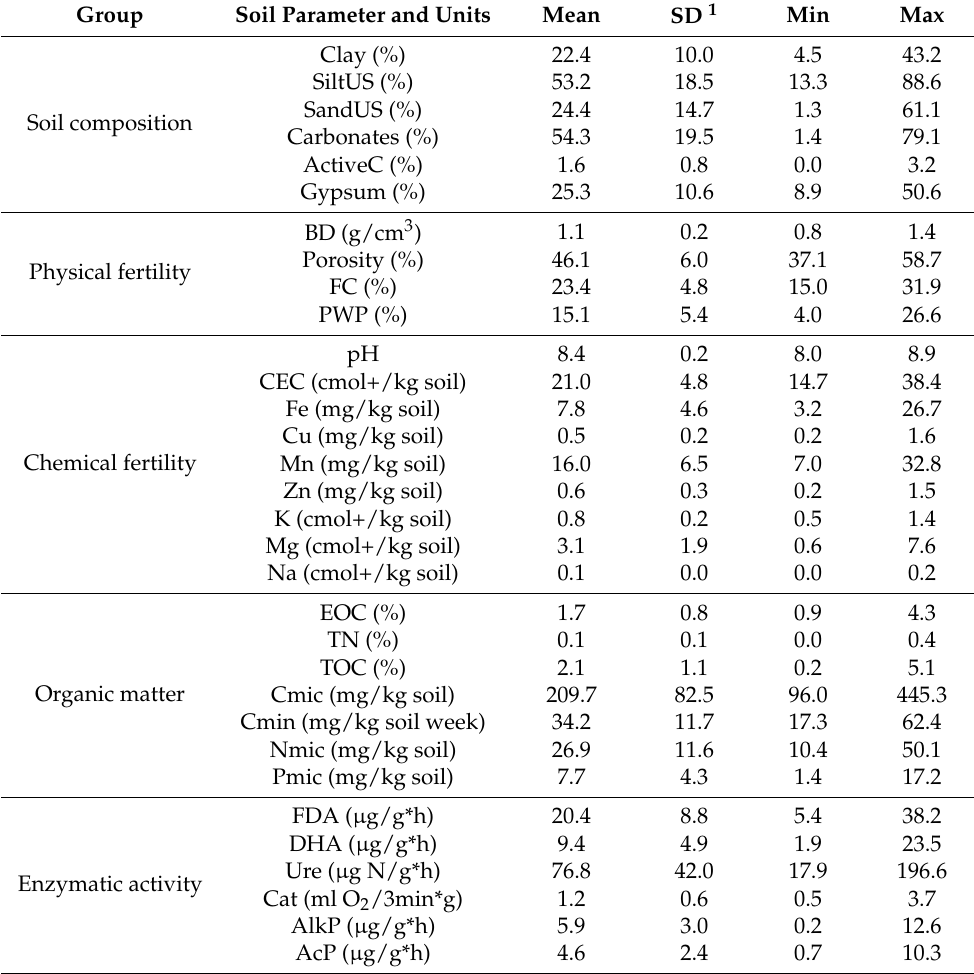
Table 2. Soil parameters used in this study and clustered into five groups (extracted from [46,47]).